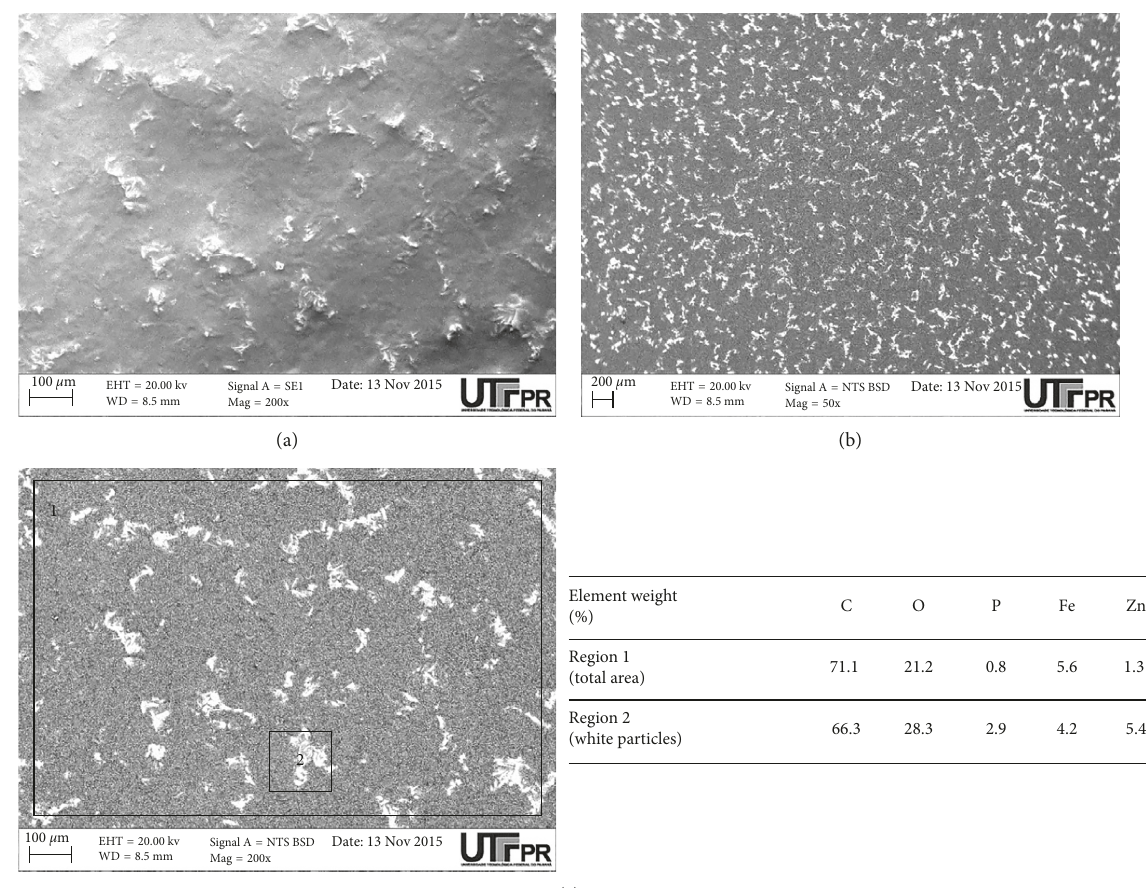
Figure 8: (a) SEM image (SE) of the basecoat surface, (b) SEM image (BSE) of the basecoat surface, and (c) zoom of the SEM image (BSE) with EDS analysis on two